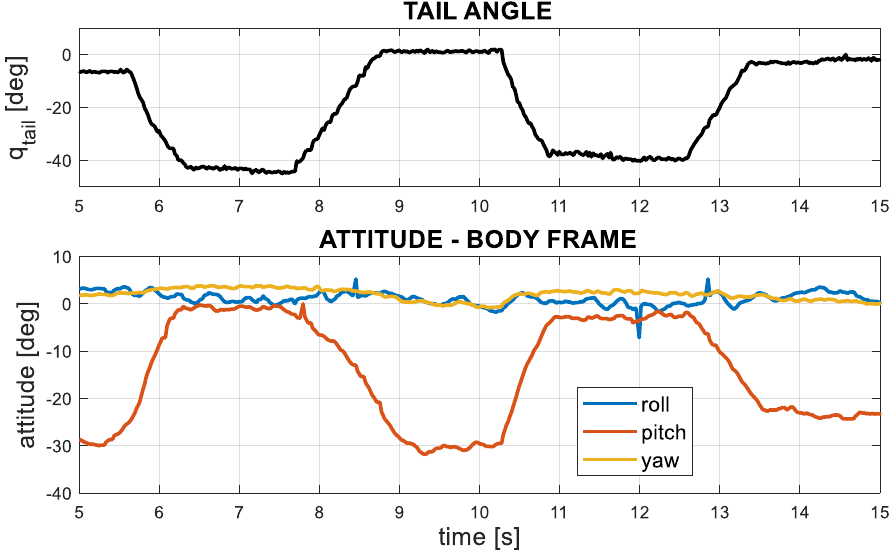
Figure 15. Variation of the pitch angle due to the moment induced by the tail.